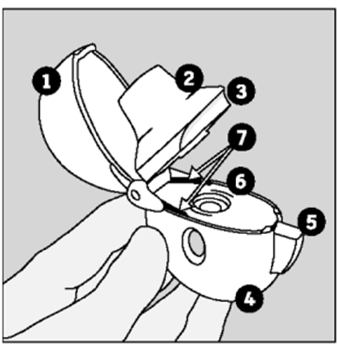
Figure 1. Diagram of the Spiriva HandiHaler [27].